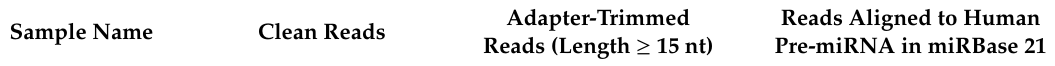
Table 2. Overview of the miRNA sequencing data in three independent PBMC donors and three independent MDM